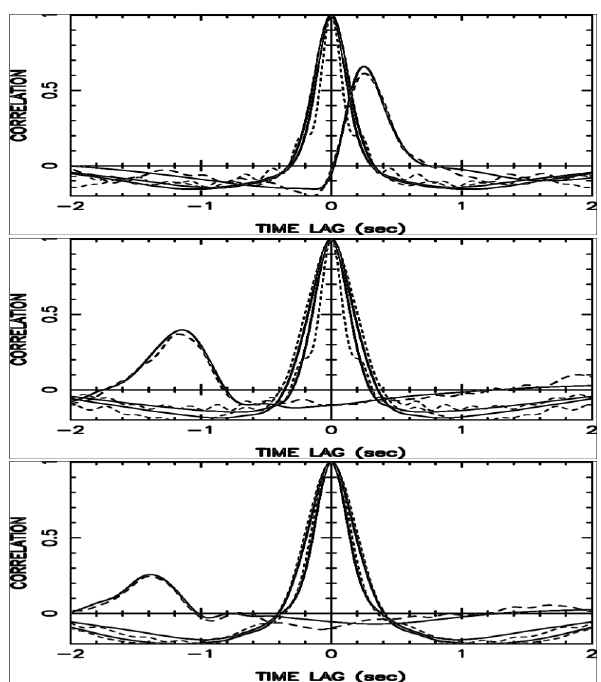
Fig. 6. An observation of the radio source J0319+415 taken on 12 May 2004, fitted using a dual-frequency weak scattering model. The top panel is a Tromsø (928MHz) – Kiruna (1420MHz) corre- lation; the middle panel is a Tromsø (928MHz) – ESR (500MHz) correlation; the bottom panel is a Kiruna (1420MHz) – ESR (500MHz) correlation. The dotted and dashed lines represent the data; the solid lines the model fit. The auto-correlation functions from both antennas and the cross-correlation function are displayed in each case. The observation is dominated by fast solar wind to which the model fitted a speed of 775kms − 1